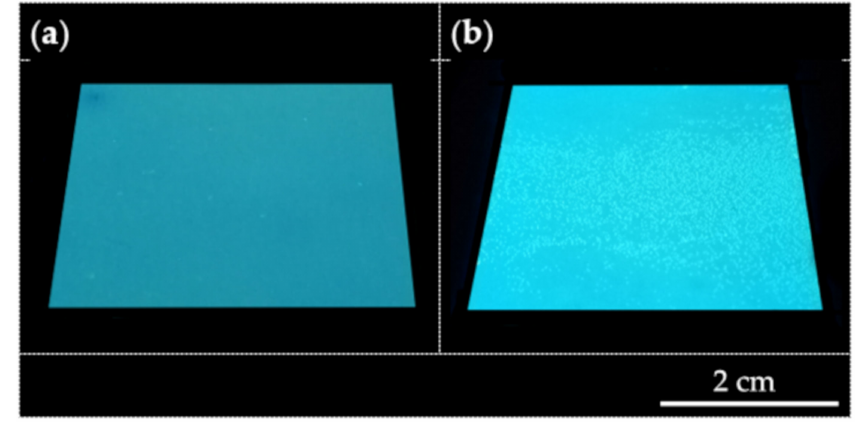
Figure 5. PPM derivatives coatings on polybenzylsiloxane-modified AA2024. ( a ) Surface coated with CO-PPM containing 13.4% of 4-octyloxy side-chains. ( b ) Surface coated with CO-PPM containing 6.1% of 4-octyloxy